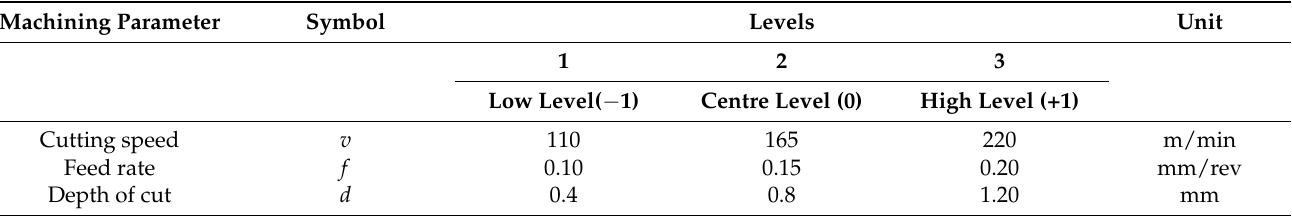
Table 3. Machining parameters and their